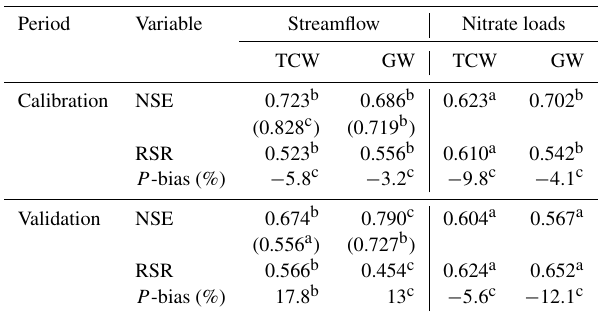
Table 5. Model performance measures for monthly streamflow and nitrate